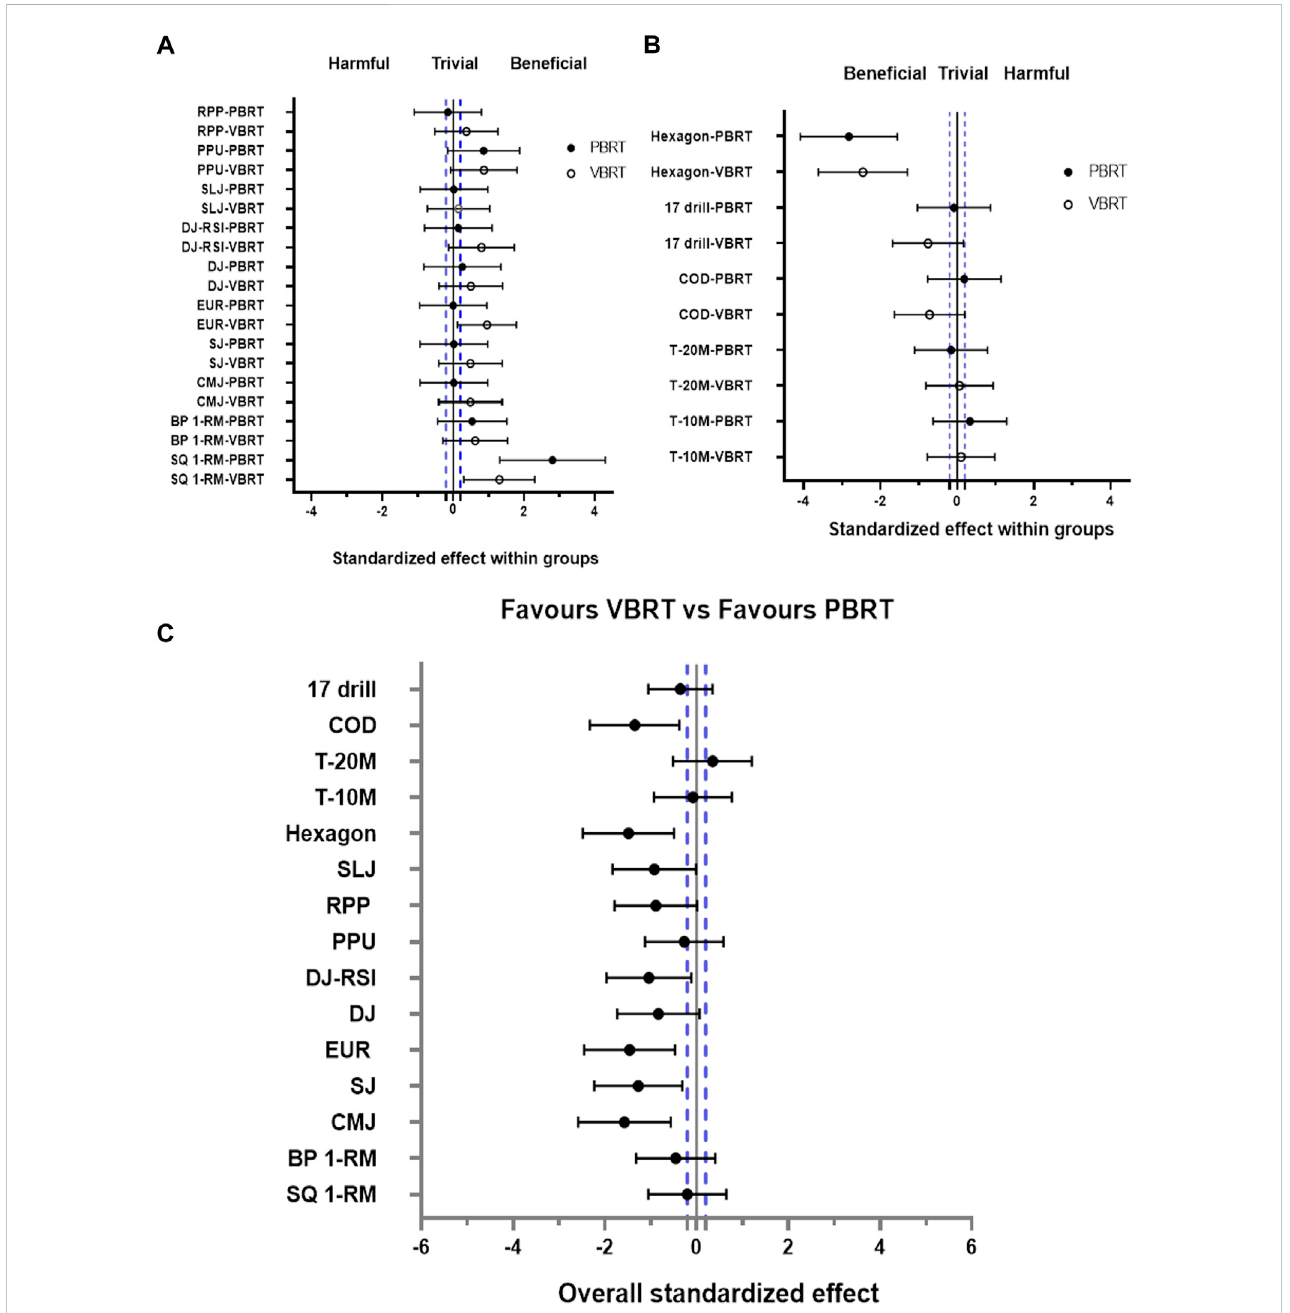
FIGURE 8 Standardized differences (90% con fi dence intervals) in all measured variables physical and athletic performance between T0 and T2 for VBRT and PBRT (A,B) ,andoverallstandardizeddifferences(90%con fi denceintervals)inallmeasuredvariablesbetweenVBRTandPBRT (C) .SQ-1RM,BP-1RM:one-repetition maximum of back squat or bench press; CMJ, SJ, DJ, SLJ: countermovement jump height, squat jump, 40 cm-drop jump, standing long jump, respectively; EUR: eccentric utilization ratio; PPU: plyometric push-up height; RPP: the relative peak power output of plyometric push-up, the peak power divided by body mass; Hexagon: hexagon agility test; T-10M, T-20M:10-, 20-m sprint time; COD: 505 change-of-direction test; 17 dirll: 17 × 15 m lines-drill